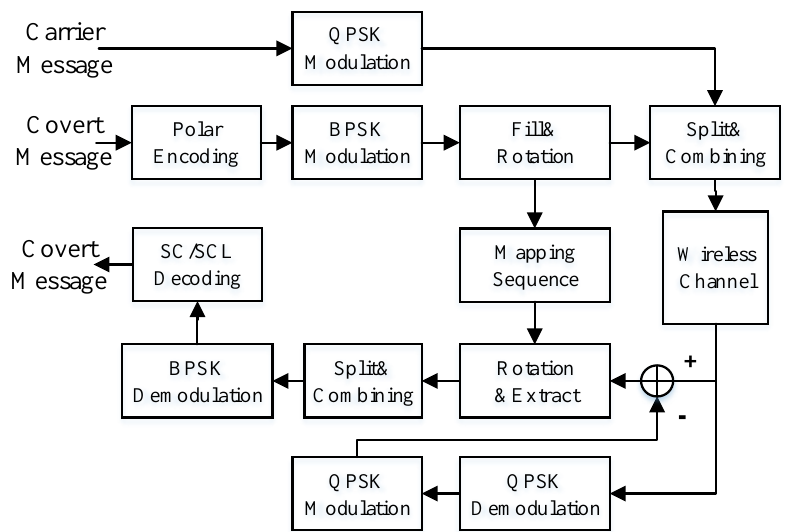
Figure 3. The schematic diagram of wireless covert communication with polarization dirty